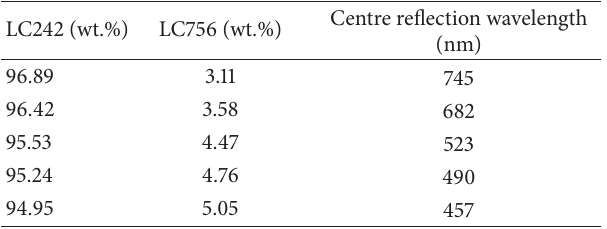
Table 1: The dominant reflection wavelengths associated with different LC242 and LC756